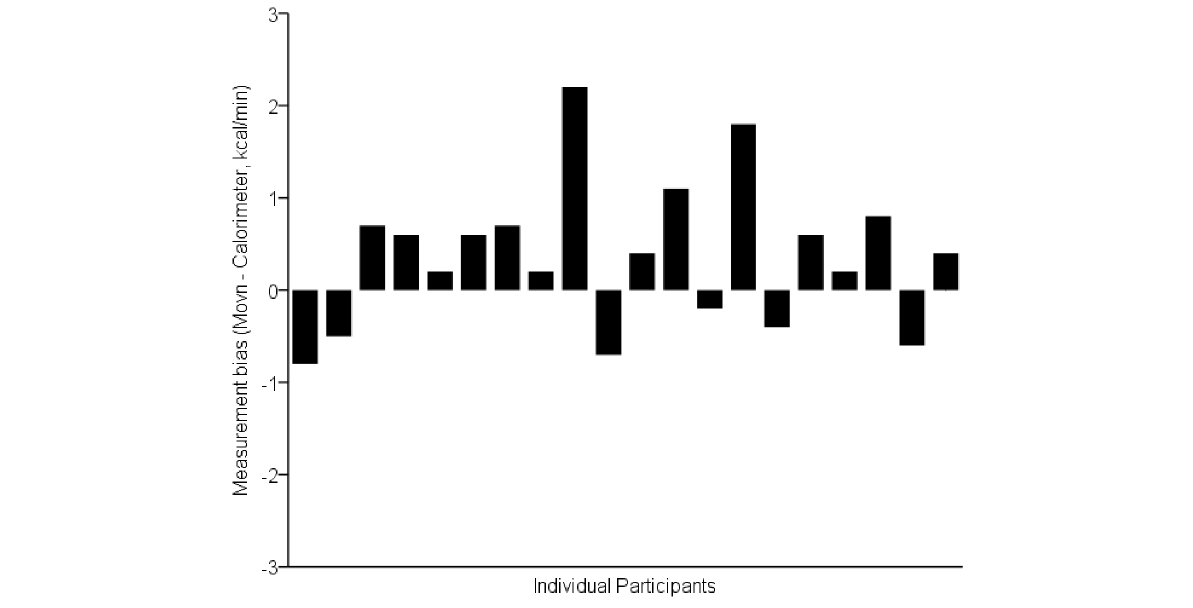
Figure 5. Supplementary analysis of the relative accuracy of measured (indirect calorimetry) and estimated (Movn app) energy expenditure (EE) during phase 1 laboratory-based activities. Mean EE measurement biases across individual